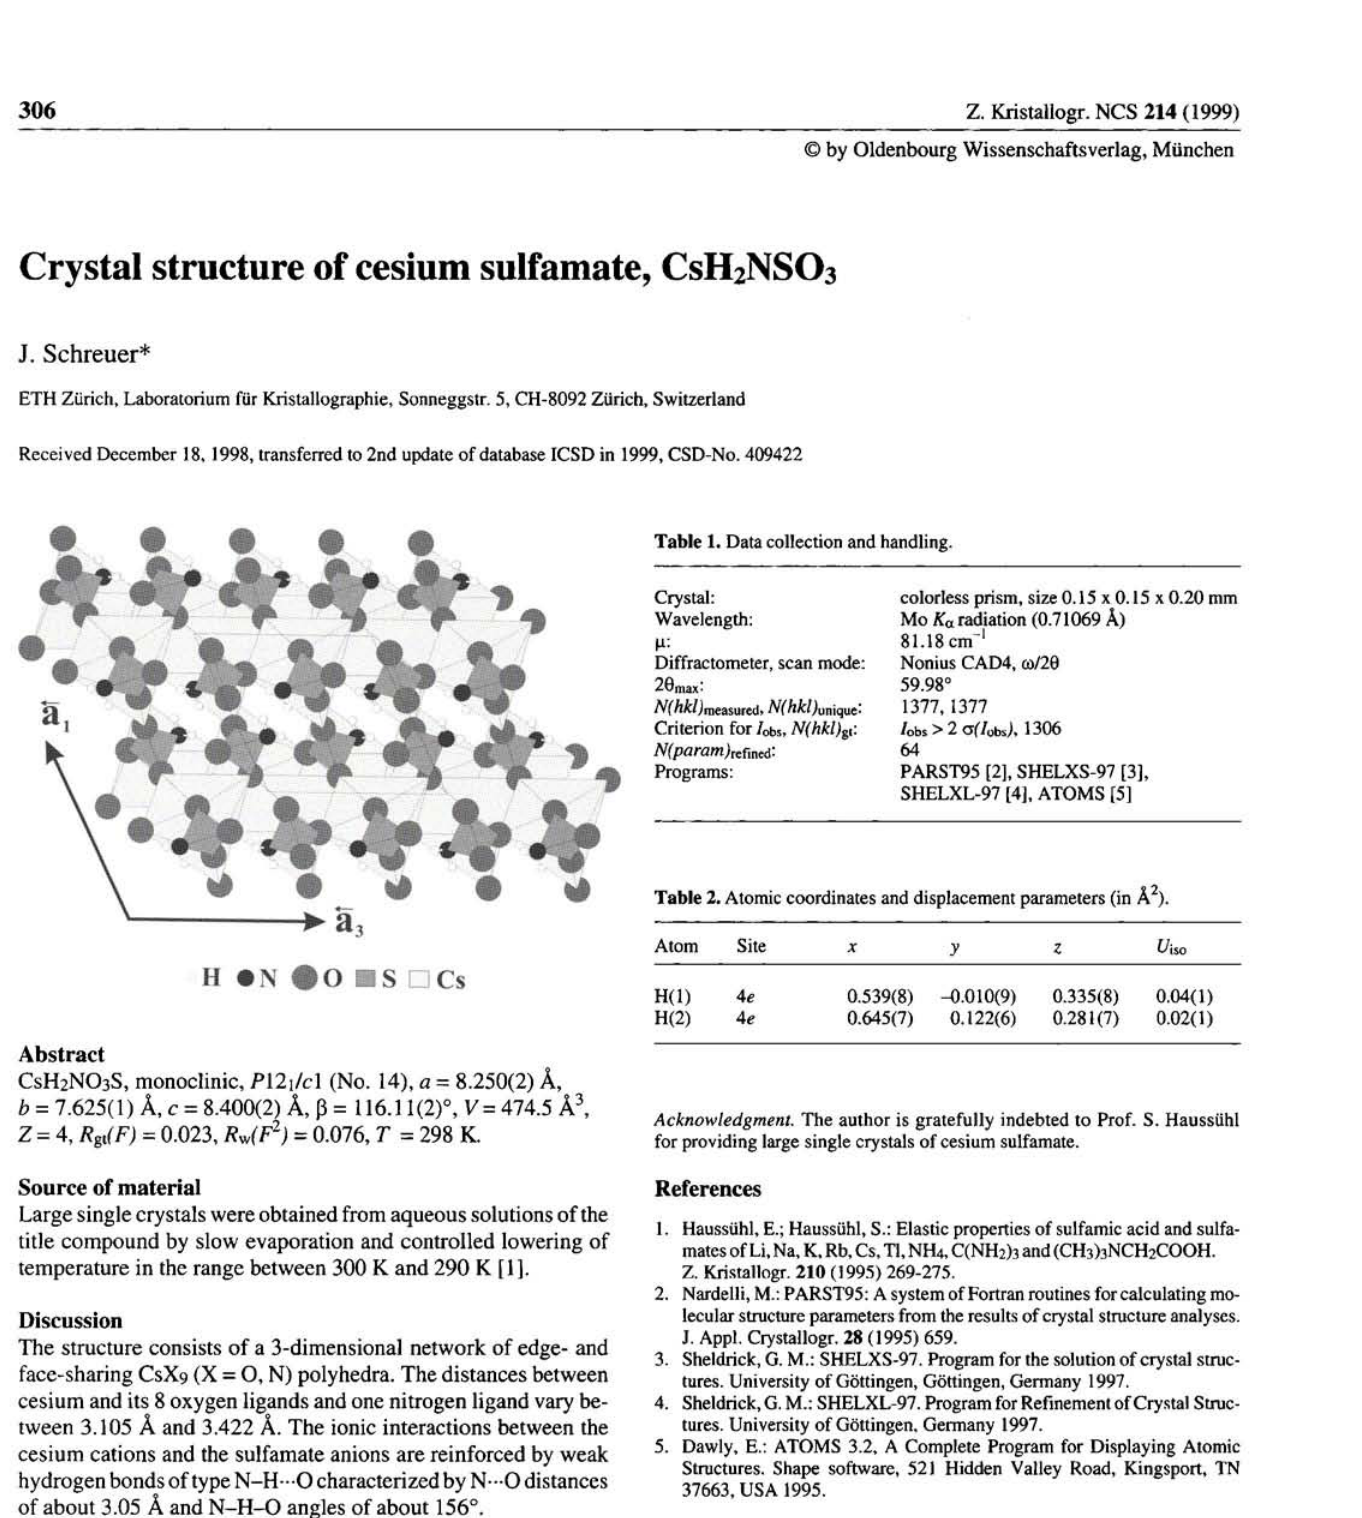
Table 3. Atomic coordinates and displacement parameters (in Â 2 ).